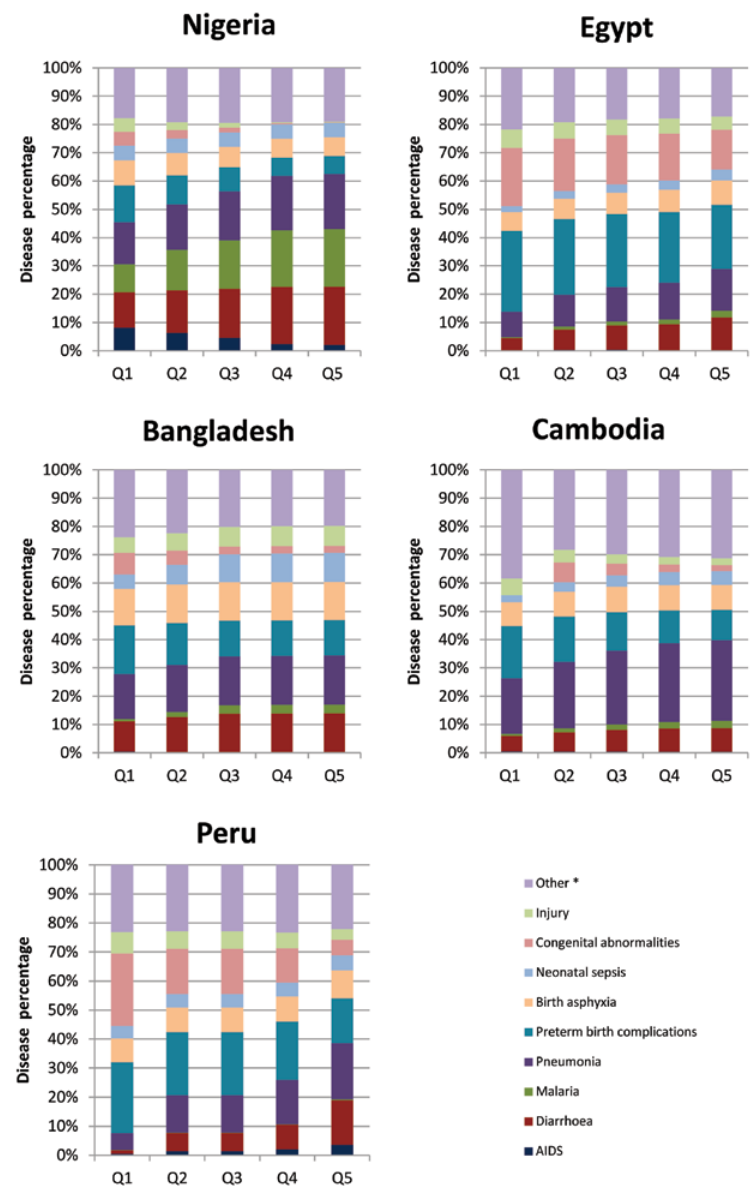
Figure 10 Modelled cause–specific child mortality by wealth quintiles in exemplar